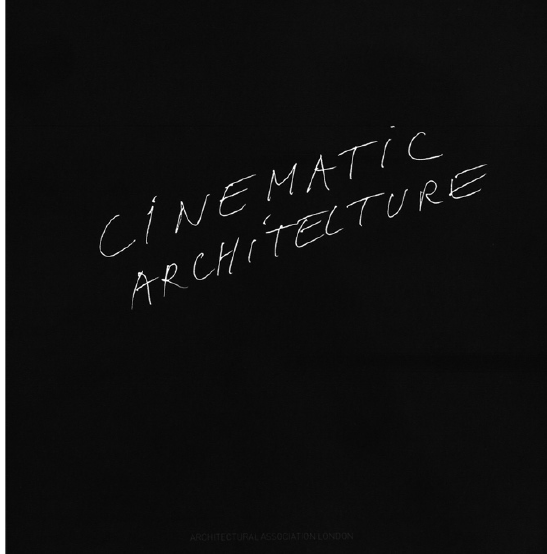
Figure 10 Cinematic Architecture, Pascal Schöning (2009). Figure 11 Hiroshima Through Light: From Light to Silence, Silence to Light, Dir. by the Author.